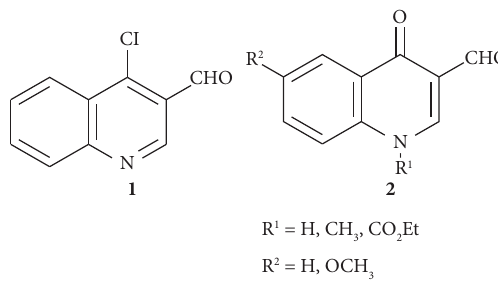
Figure 2: Structures of 3-formyl (quinoline 1 and 4-quinolones 2 ) used in the Wittig